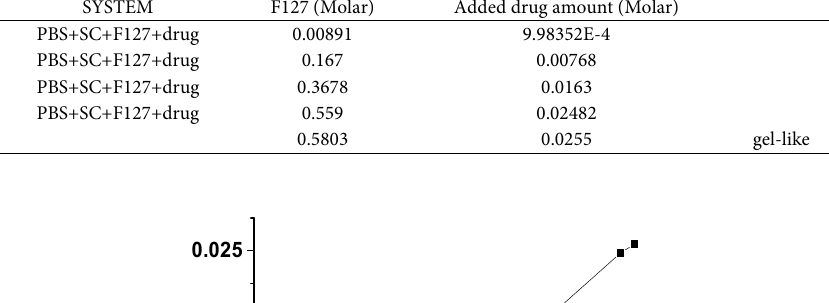
Table 6. Titration of turbid solution of F127, SC, drug in PBS with F127 and drug ([PBS]=Const., [Sodium Caprylate (SC)]= Const.). SYSTEM